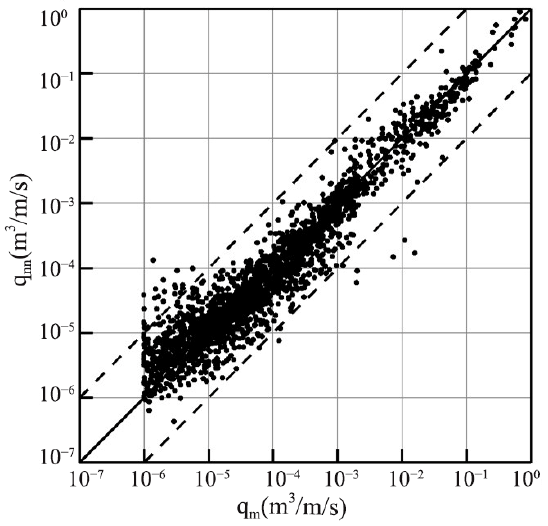
Figure 8. Comparison of the estimated value of the ANN model with the experimental value of all datasets.